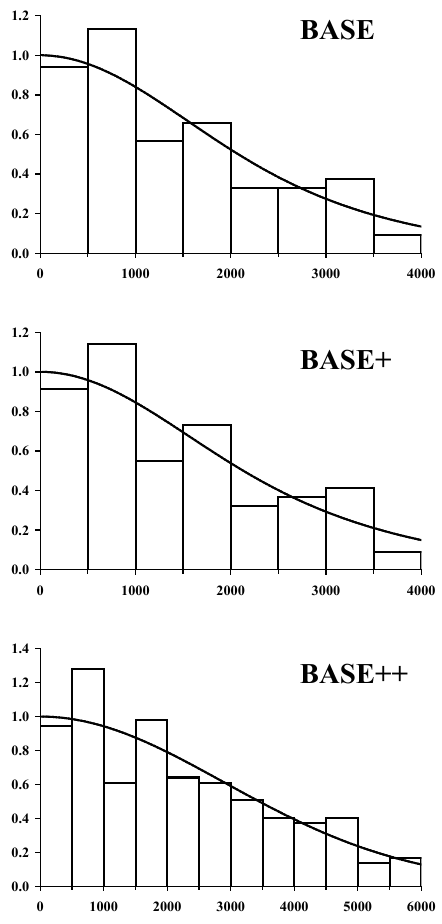
Fig. 2. Detection functions for the base, base+ and base++ analyses. Distances in